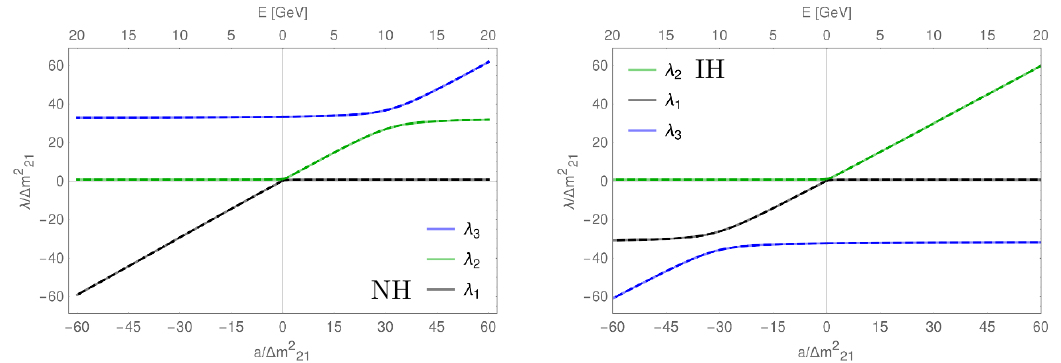
, for both neutrinos 21